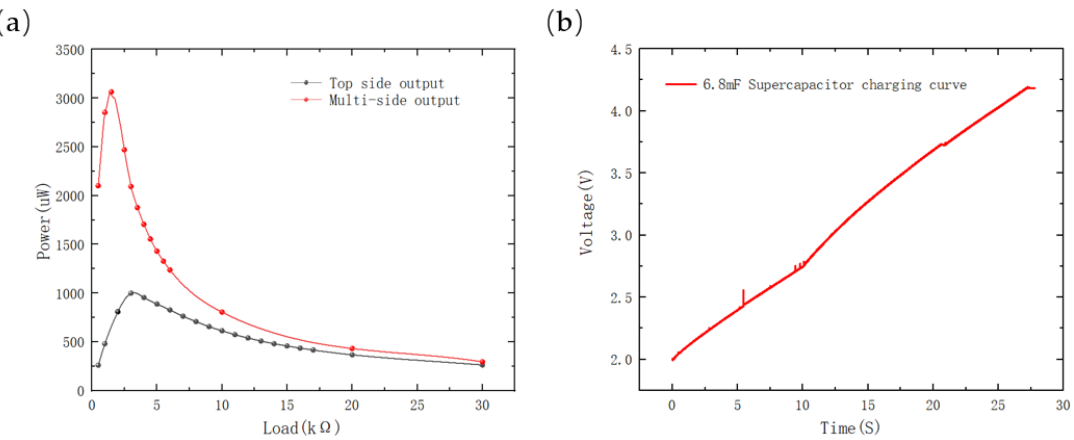
Figure 12. ( a ) The output power of top-sided PV and multi-sided PVs; ( b ) charging curve of a 6.8 mF SC.